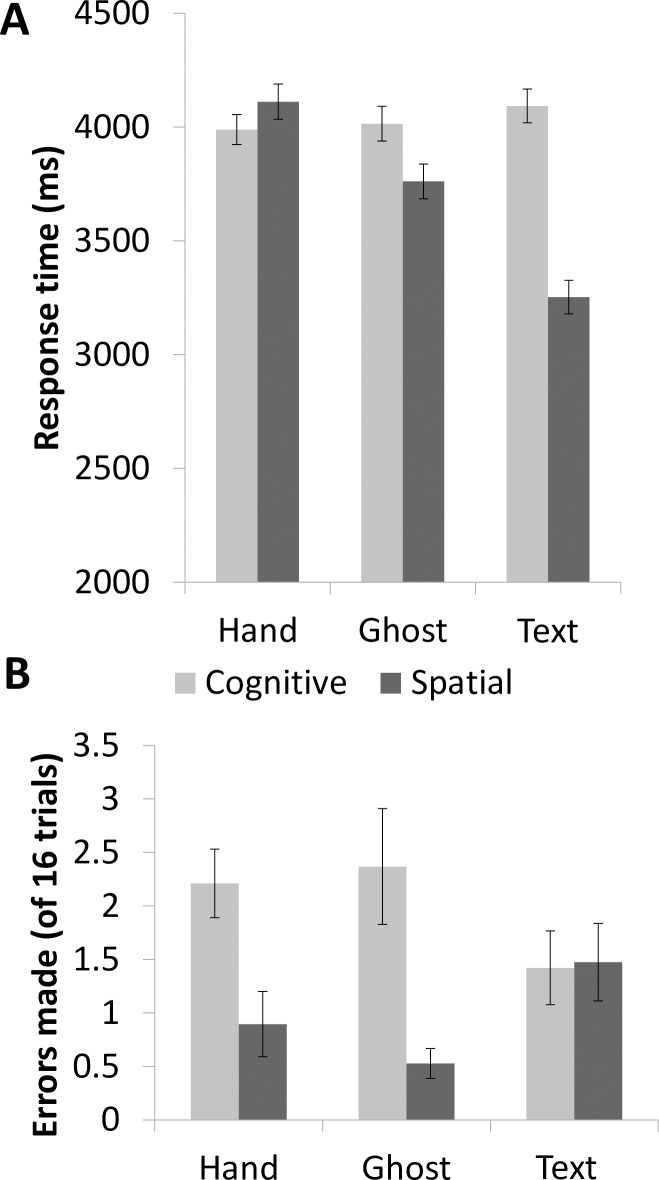
Reaction times (A) and error rates (B) when participants performed the task during fMRI. Error bars show standard errors.